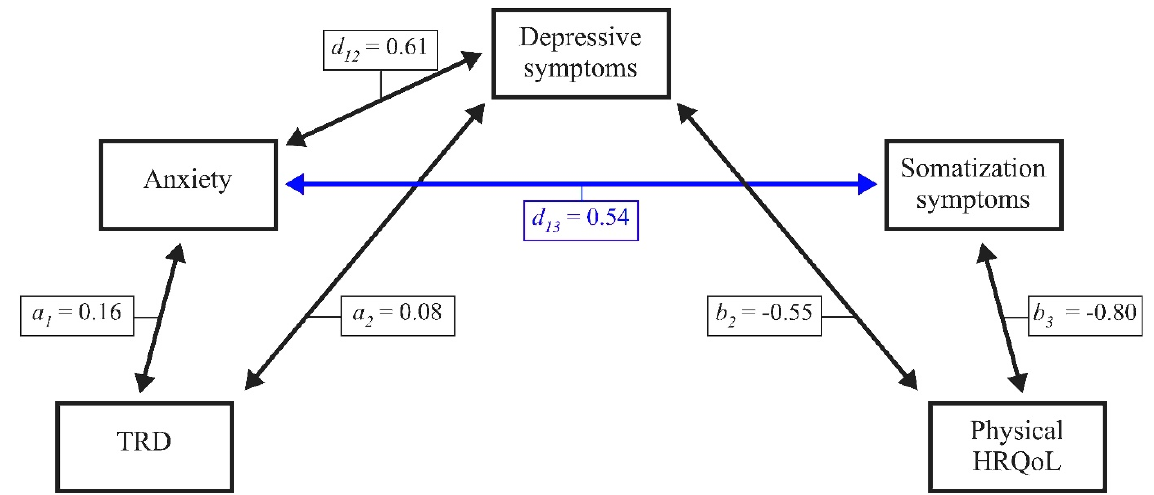
Figure 4. Anxiety, depressive symptoms, and somatization symptoms completely mediate the effect of TRD on physical HRQoL in male patients with chronic tinnitus. TRD = tinnitus-related distress; HRQoL = health-related quality of life. Numbers indicate unstandardized multiple regression coefficients. Blue lines indicate effects that are significant in male patients only.